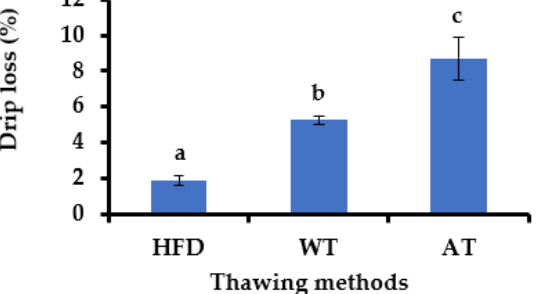
Figure 2. Drip loss (%) of frozen raw mackerel after thawing process using high-frequency defroster (HFD), water thawing (WT), and air thawing (AT). The data are shown as the mean ± standard error of the mean (SEM). The means with different letters are significantly different between thawing methods (Tukey’s test, n = 3, p < 0.05).